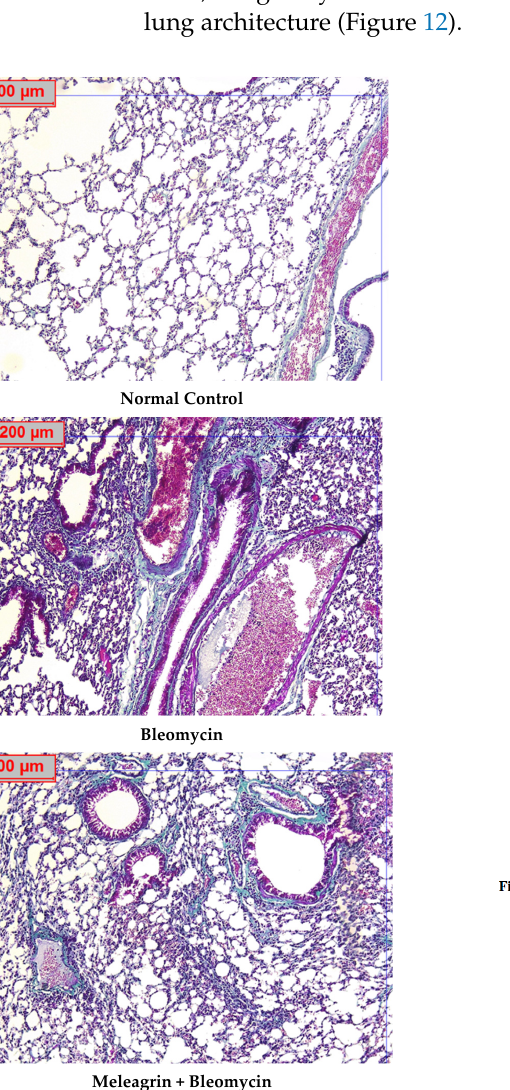
Figure 12. A photomicrography of lung tissue (Masson’s trichrome, ×100). Normal control group and meleagrin group: showing normal bronchial and alveolar walls. Bleomycin group: showing increased fibrosis with definite damage to lung structure. Bleomycin + Meleagrin group: showing moderate thickening of walls with improved lung architecture. Meleagrin + Bleomycin group: showing minimal thickening of walls without detectable damage of lung architecture. Fibrosis score is expressed as mean ± SD and analyzed using one-way ANOVA followed by Bonferroni’s post hoc test ( n = 8). * significantly different vs. the normal control group; # significantly different vs. the meleagrin group; ^ significantly different vs. the bleomycin group; $ significantly different vs. the bleomycin + meleagrin group. Differences were considered significant at p < 0.05. bronchial tissue with intact walls in both the normal control group and the meleagrin